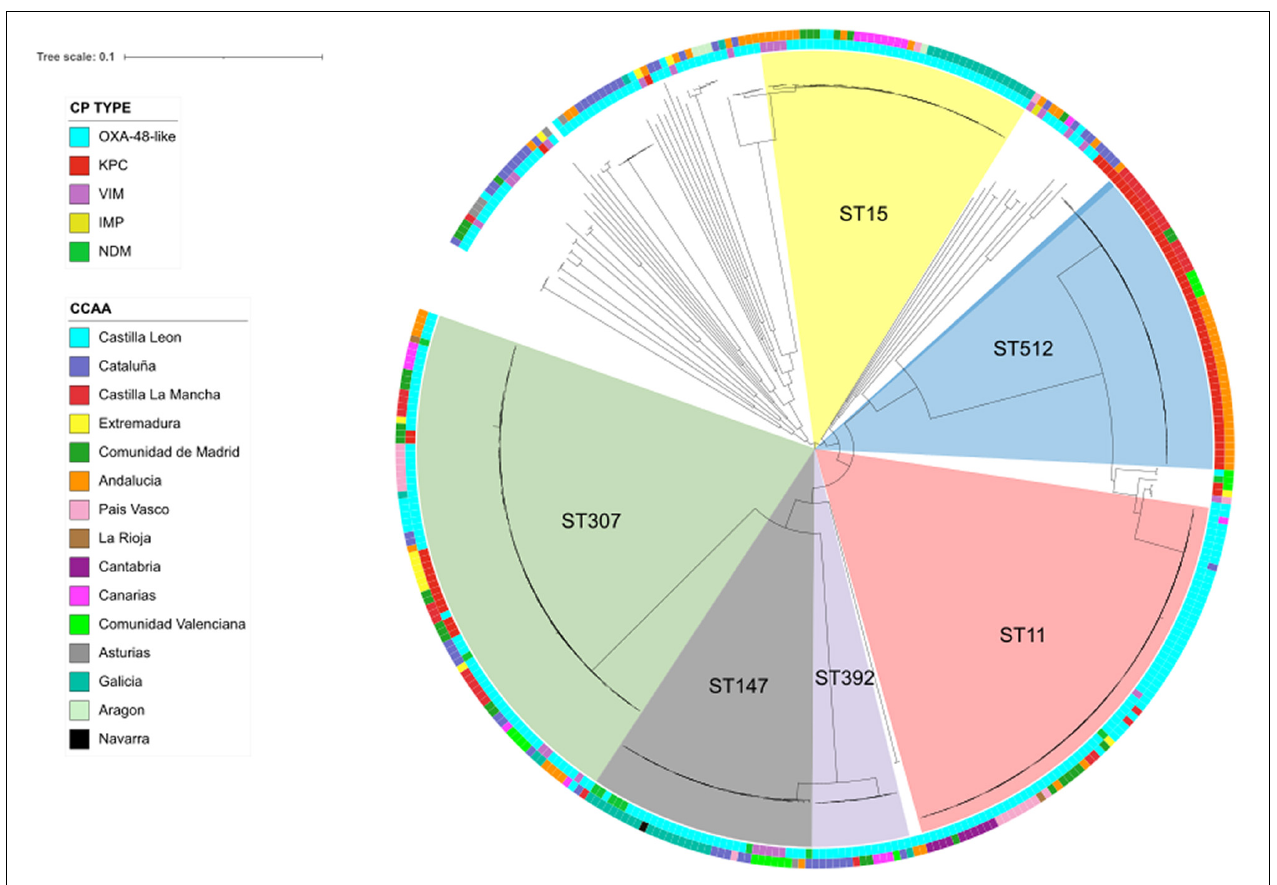
FIGURE 2 | Population structure of carbapenemase-producing Klebsiella pneumoniae isolates: maximum-likelihood tree showing the relationship between isolates, with more frequent STs displayed in the inner ring and labeled. The inner ring colors indicate the carbapenemase type (CP type); the outer ring colors indicate geographical distribution (CCAA: autonomous communities); and branch lengths are indicative of the number of SNPs.